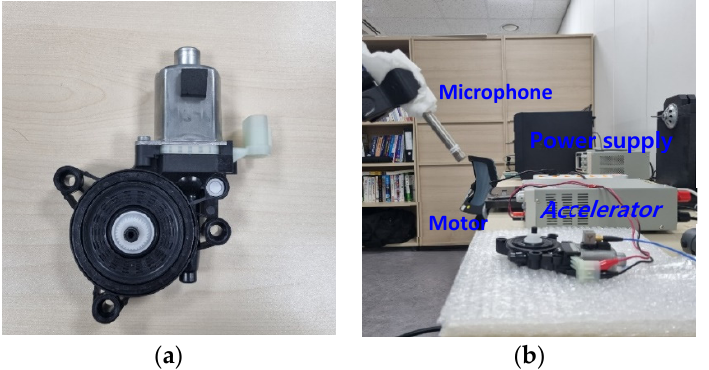
Figure 3. The motor and measurement method used in the experiment: ( a ) Vehicle window brushed DC motor used in the experiment; ( b ) equipment used in the experiment: Microphone, power supply, accelerometer, brushed DC motor.